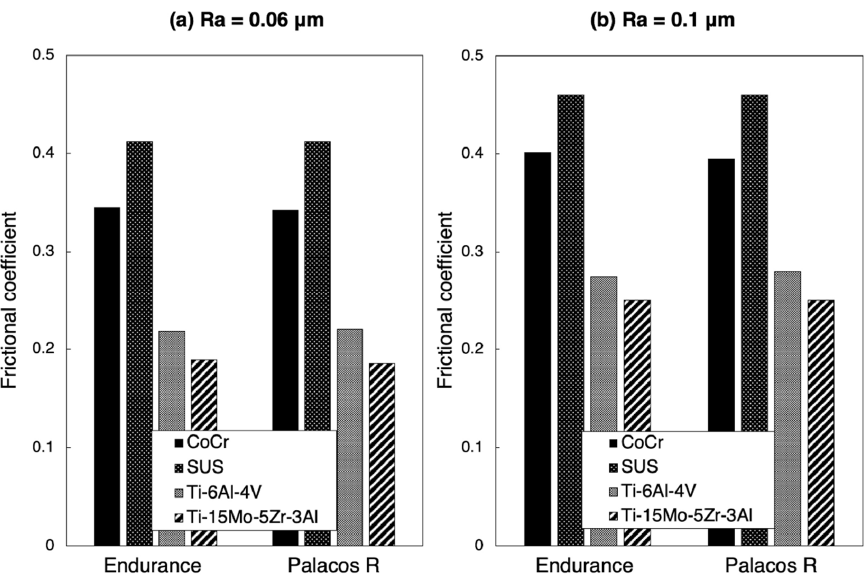
Figure 8. Frictional coefficient calculated by the power approximation fitted curve: ( a ) Ra = 0.06 μ m and ( b ) Ra = 0.1 μ m. The comparison of frictional coefficients in the metal samples is shown in Tables 3 and 4. By using Endurance with a surface roughness of Ra = 0.06 μ m, the frictional coeffi- cient in CoCr was significantly lower than that in SUS ( p = 0.0073). By using Endurance